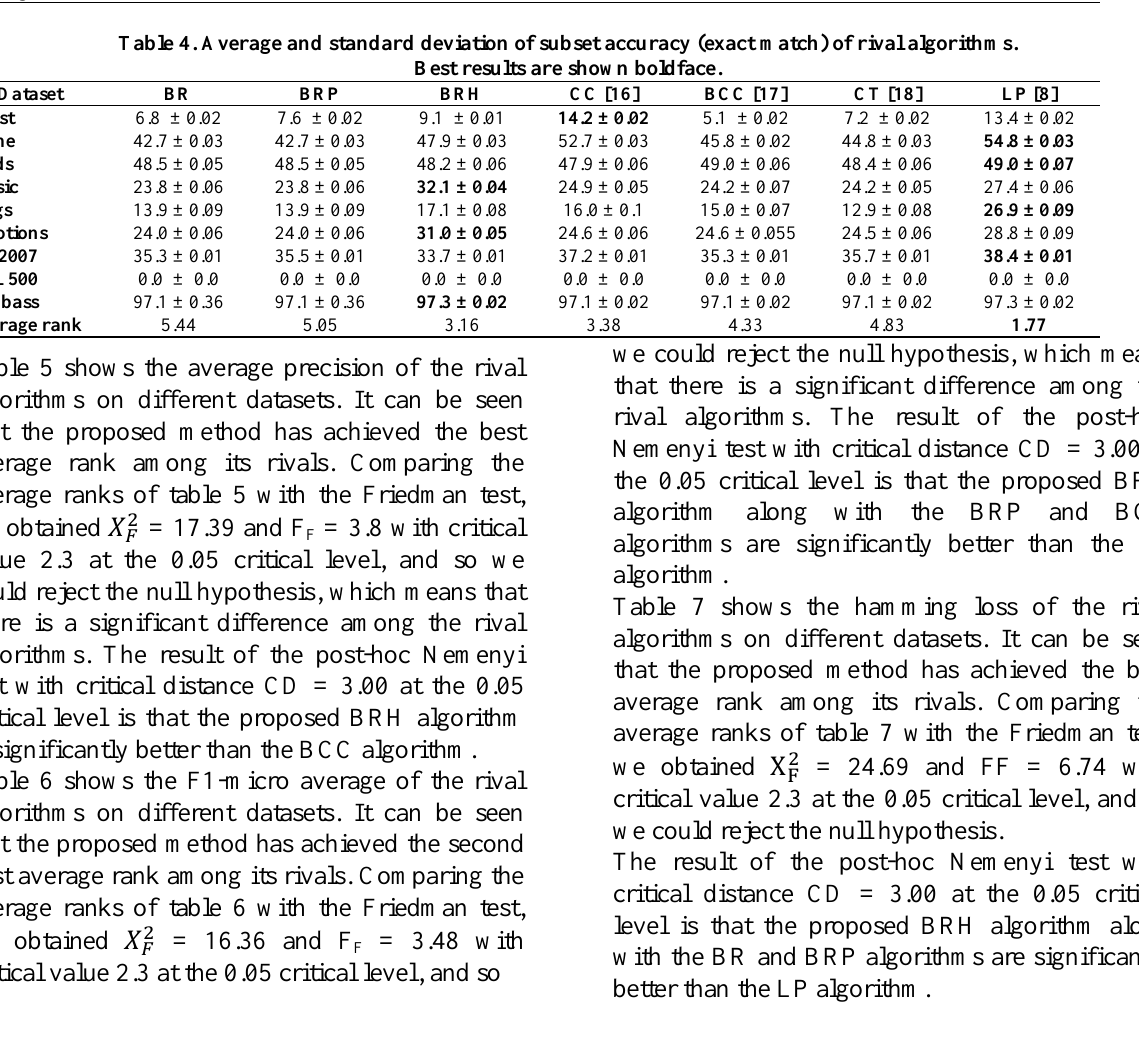
Table 5. Average and standard deviation of average precision of rival algorithms.